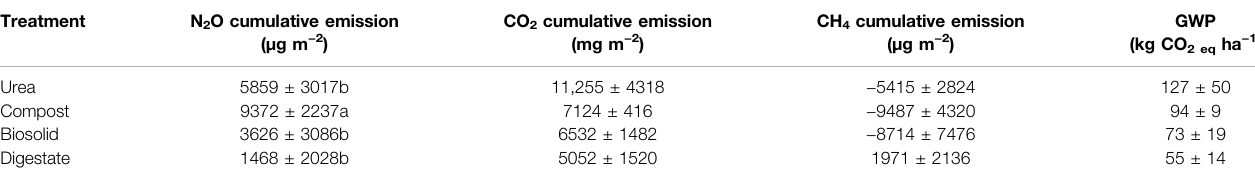
TABLE 2 | Cumulative greenhouse gas emission and global warming potential from soils amended with urea and biobased residues during the 2021 spring freeze- thaw event.